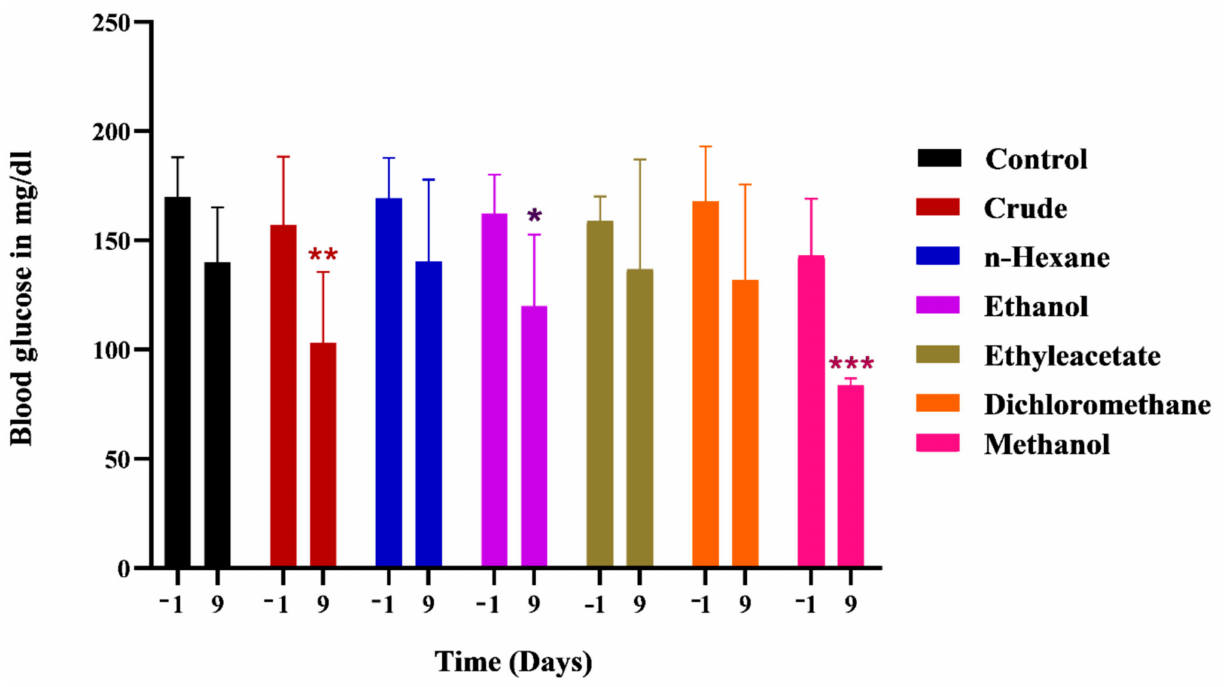
Figure 7. Effects of M. oleferia on glycemic levels (mg/dl) following sciatic nerve lesion. *, **, *** show the significance of results